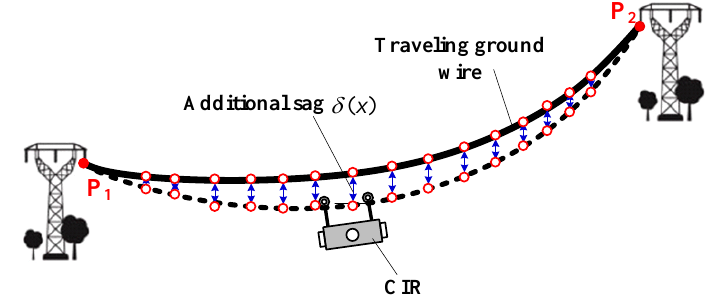
Figure 4. Additional sag of the walking ground wire.